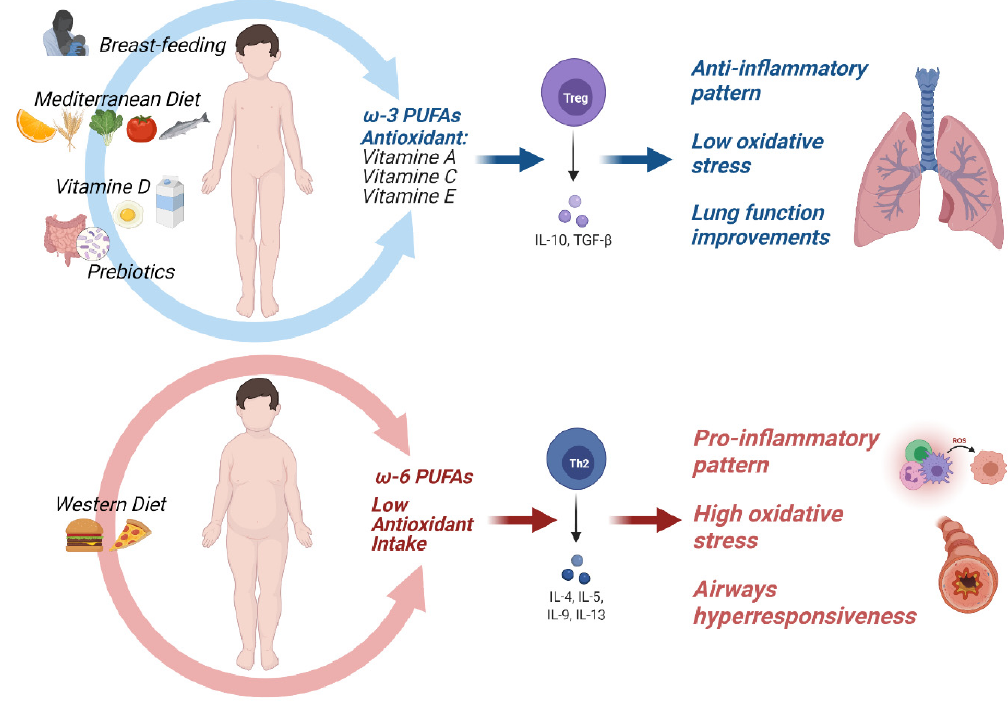
Figure 4. Factors implicated in asthma prevention and